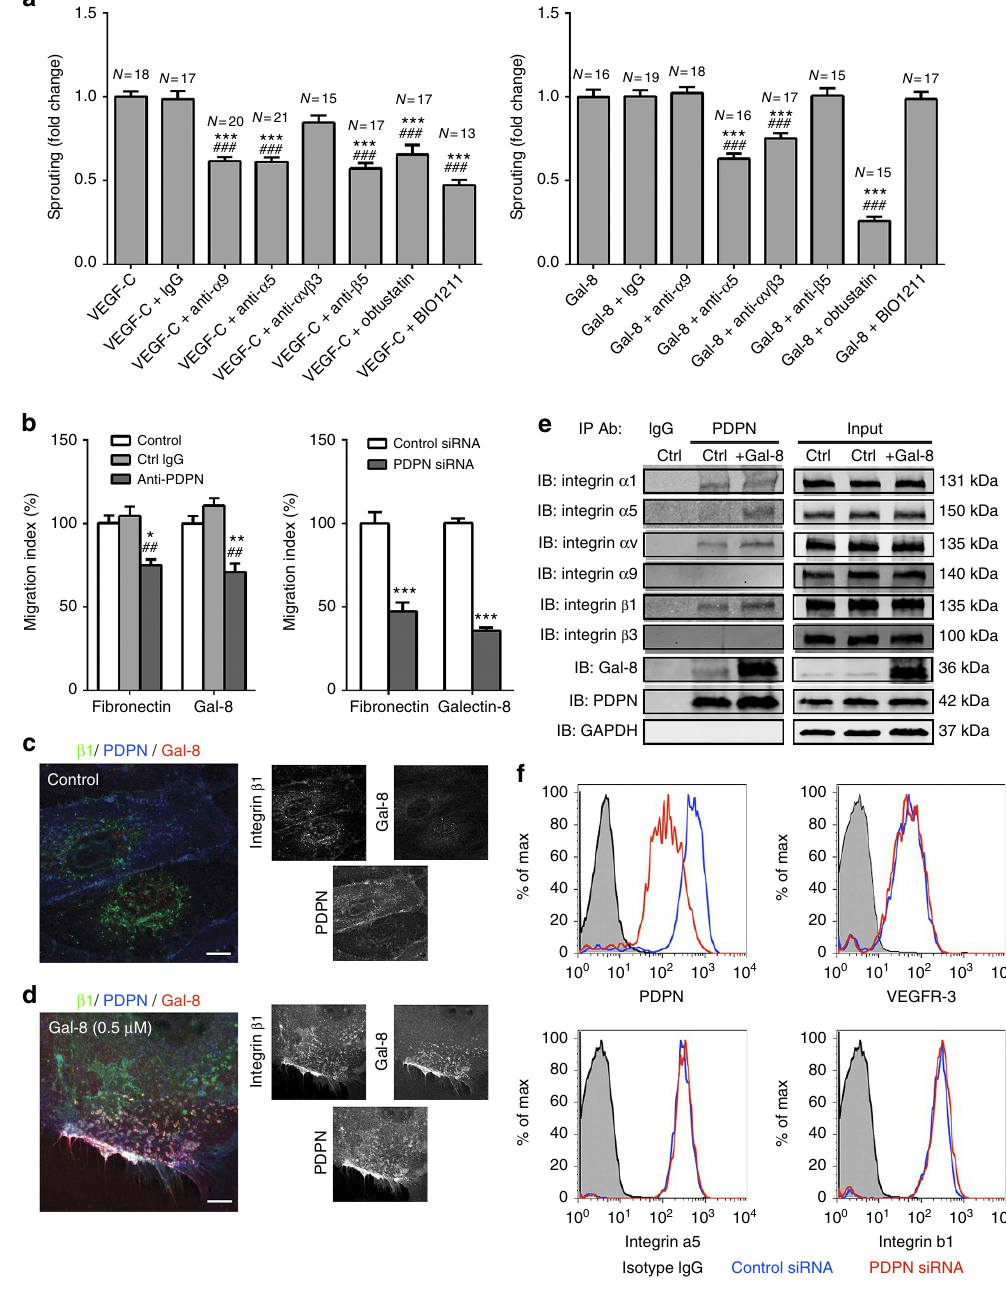
2 NATURE COMMUNICATIONS|7:12063|DOI: